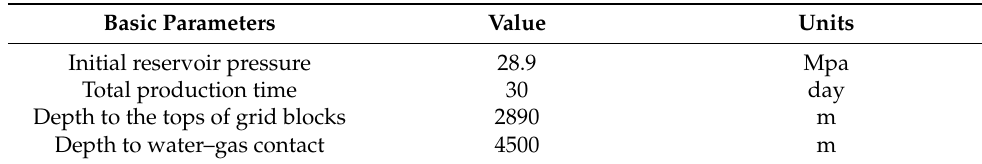
Figure 2. Numerical simulation of the shale gas fracturing horizontal well. Table 1. Basic gas reservoir parameters.